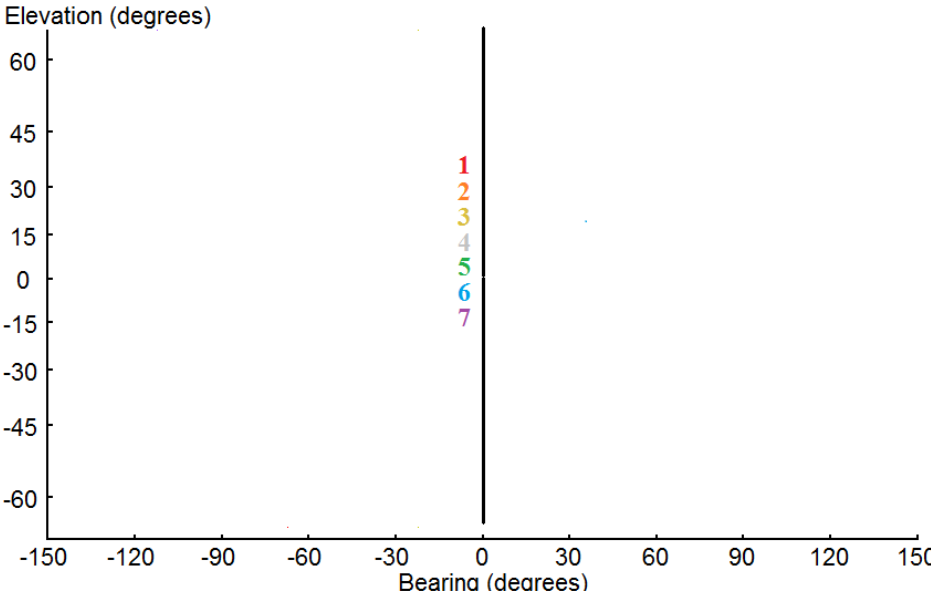
Figure 3. Skeletonised synthetic-aperture image of the field of audition in a Mercator projection. Lambda circles are shown for seven discrete angles as the head nods (or pitches) from 67.5° facing upwards (index 1), in 22.5° increments, to 67.5° facing downwards (index 7,) with respect to the mean forward facing position (0°, index 4). Since all lambda circles are coincident, they are represented by the colour black.